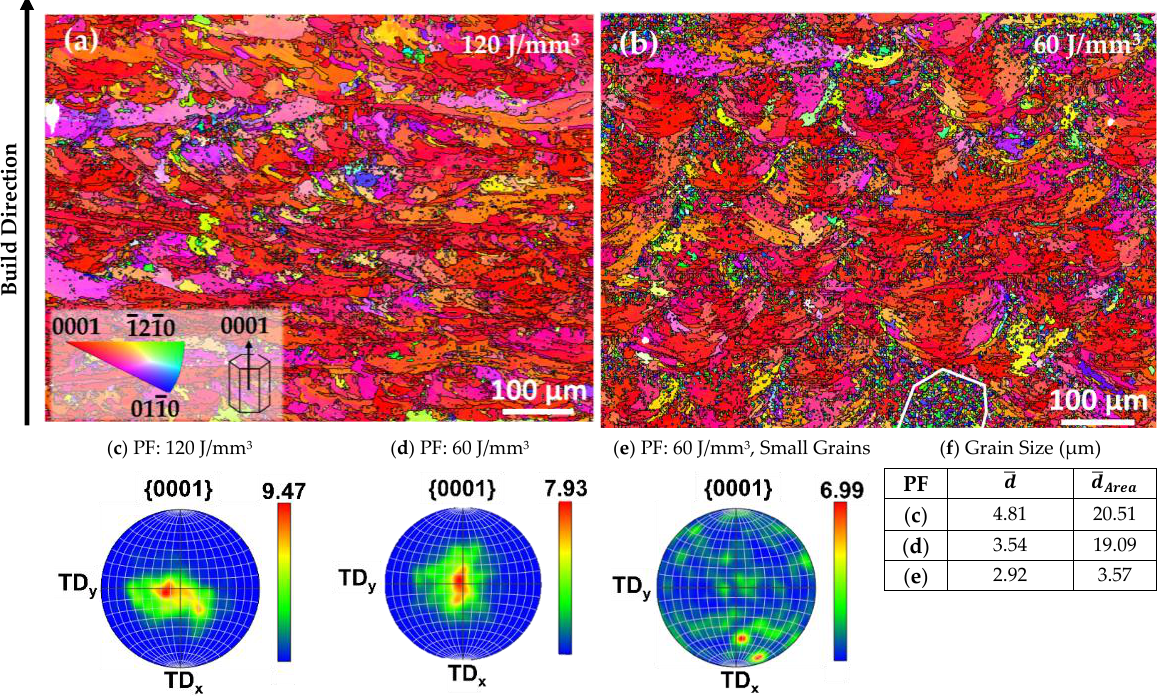
Figure 4. EBSD orientation map of ( a ) a sample produced with 120 J/mm 3 , ( b ) a sample produced with 60 J/mm 3 , with an area with a smaller grain size circled. An IPF color key valid for both maps is inserted in ( a ). In both maps, the IPF color is set to represent the crystallographic direction in the transverse plane in order to highlight the strong basal texture. This corresponds to the grains having the crystallographic orientation represented in the schematics of the hcp unit cell, i.e. a red colour means a crystal orientation of 0001 in the build direction. ( c – e ) include the PFs for the 120 J/mm 3 sample, 60 J/mm 3 sample, and the area with smaller grains circled in ( b ), ( f ), respectively. The grain sizes are defined for the areas related to the three PFs. The build direction is upward in the images. No differences were observed between the XRD spectra obtained for the two samples (Figure 5). Analyzing the XRD spectra, most peaks correspond to α-Mg. Peaks corresponding to Y 2 O 3 were found in the spectra for the processed material, although not in the spectra of the powder. The oxygen- and yttrium-rich regions observed in the EDS are thus likely be Y 2 O 3. Peaks corresponding to Mg 3 Nd were found in both spectrums. Moreover, in the printed material a number of peaks and shoulders that could be related to Mg 24 Y 5 were established. The difference in relative intensity between the α-Mg peaks in the spectra of the processed material is different from that of the powder. This change in relative intensity of the peaks is related to the strong texture in the processed material [55].